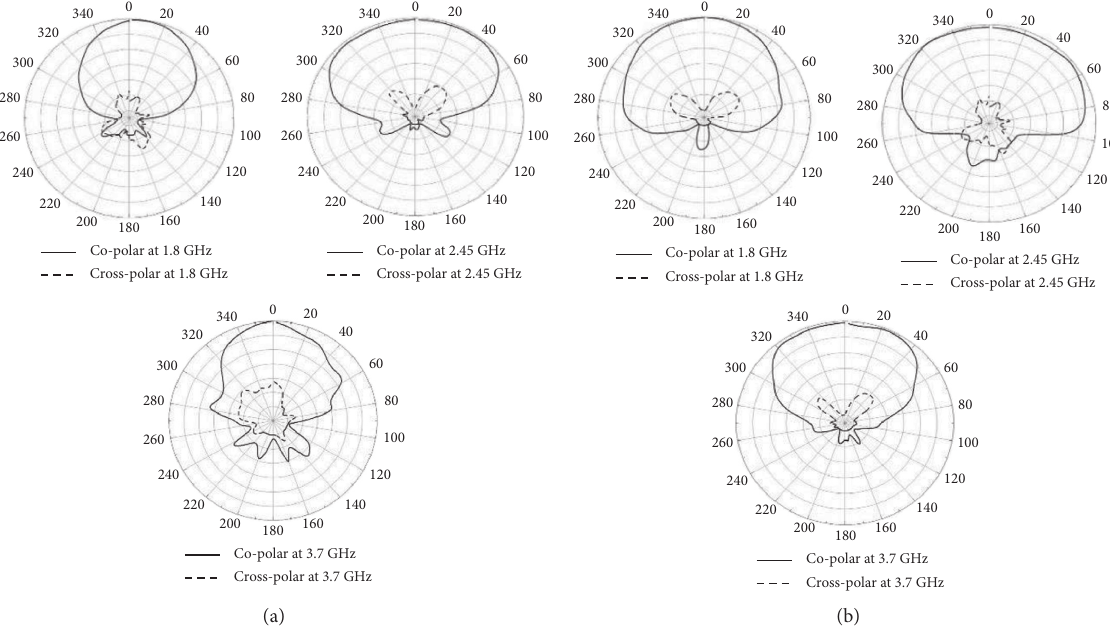
Figure 18: The radiation pattern measurement results. (a) E-plane at 1.8GHz 2.45GHz and 3.7GHz. (b) H-plane at 1.8GHz 2.45GHz and